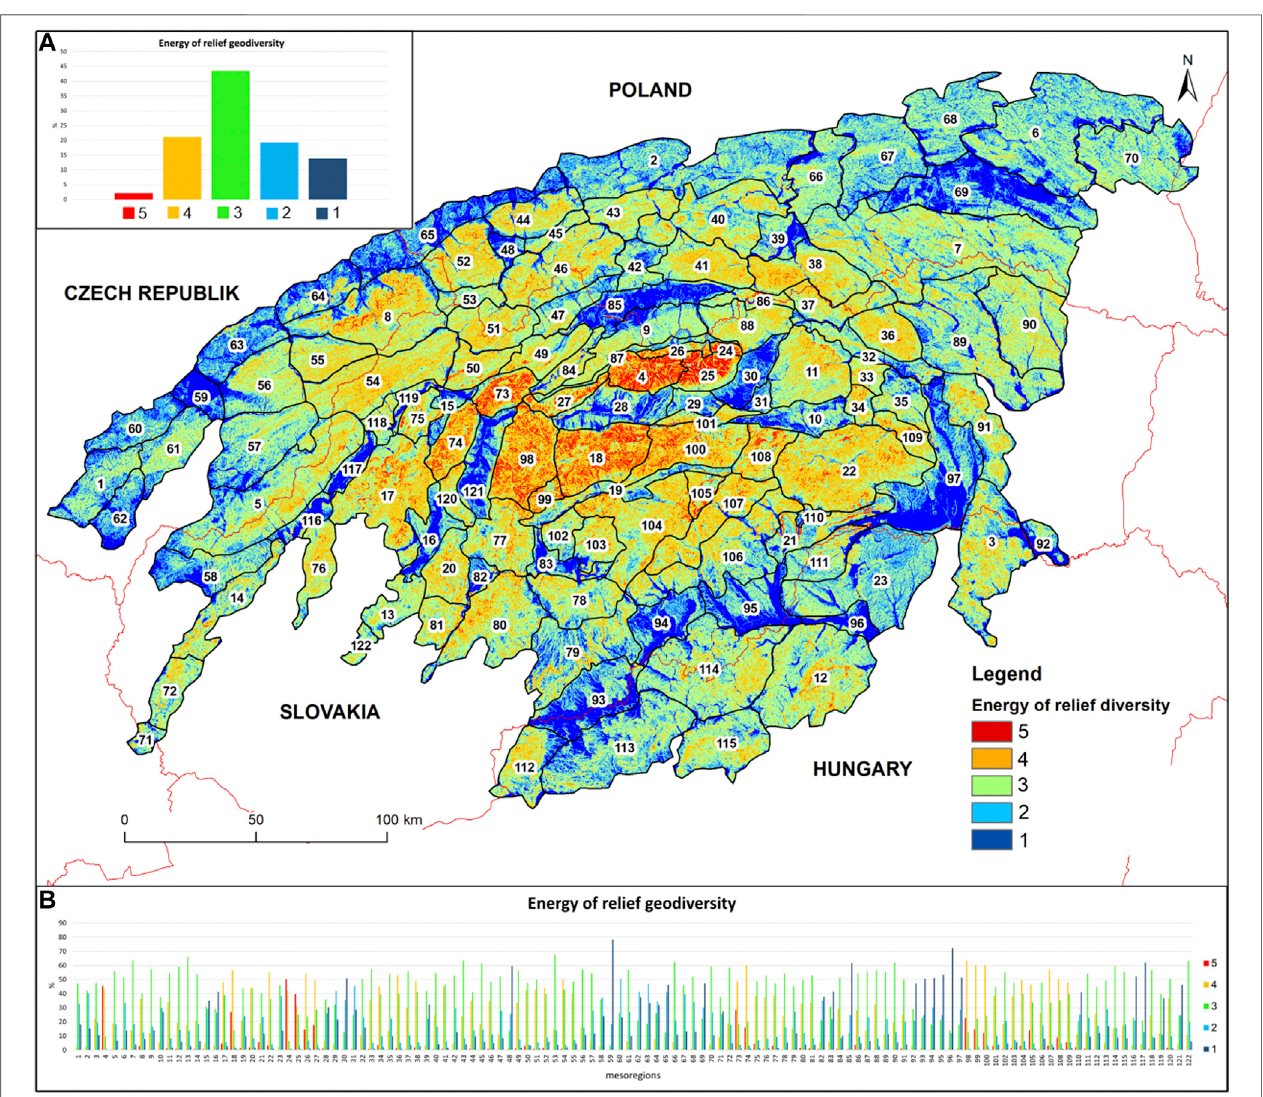
FIGURE 4 | Energy of relief geodiversity map: 1: 0 – 10 m, 2: 10 – 20 m, 3: 20 – 50 m, 4: 50 – 100 m, 5: 100 – 10,000 m. For numbers of mesoregions, see Figure 2 . Source: own research.